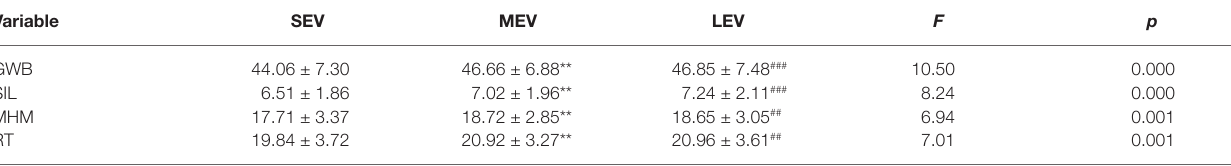
TABLE 3 | The results of the variance analysis of the effect of physical exercise on the subjective well-being in college students. Variable